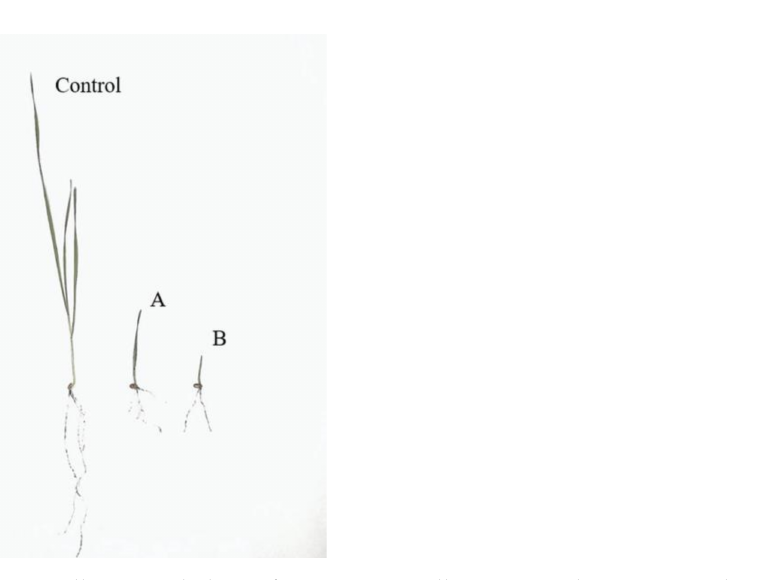
Figure 2. Seedling morphology of T. aestivum seedlings exposed to 2% microplastic derived from bottle caps from ( A ) Singapore and ( B ) Lahti in the soil for seven days compared to a control. A correlation between the root and shoot growth was established by Liao et al. [32] and Palta et al. [33] as adverse effects on the root development would undoubtedly impact the shoot growth due to a reduced capacity for taking up of the necessary nutrients and